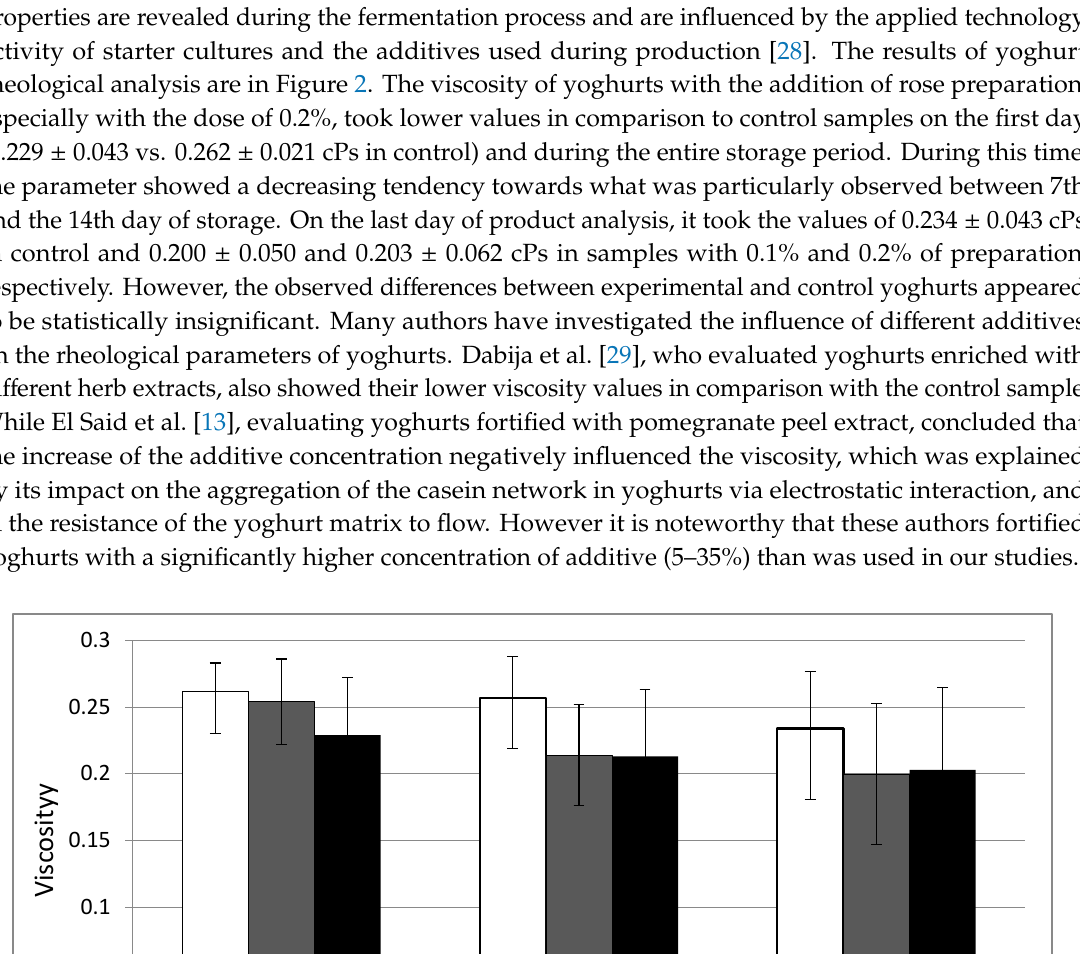
storage. (cid:3) —Control, (cid:4) —0.1% and (cid:4) —0.2% addition of Rosa spinosissima fruits